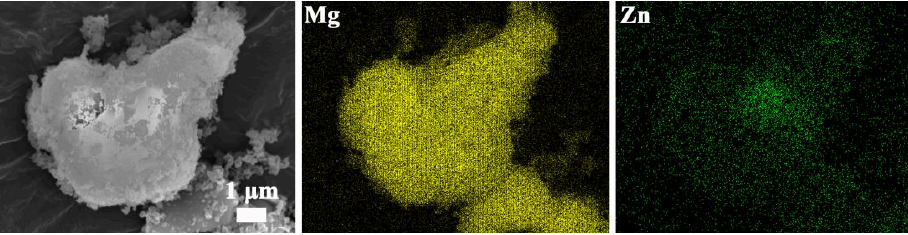
Figure 10. The element mapping images of MgH 2 -5 wt% ZnO composite after